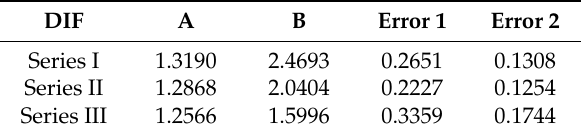
Table 7. The estimated results for di ff erent concrete using Equation